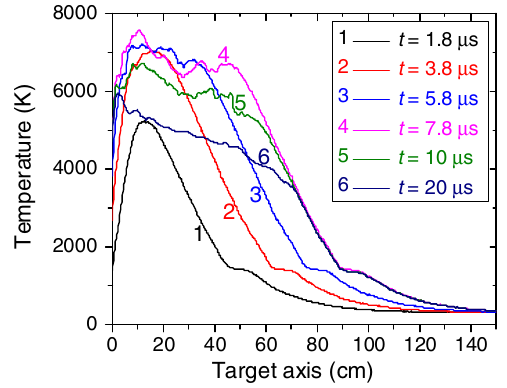
FIG. 7. Temperature along the target axis at different times t ¼ 1 . 8 , 3.8, 5.8, 7.8, 10, and 20 μ